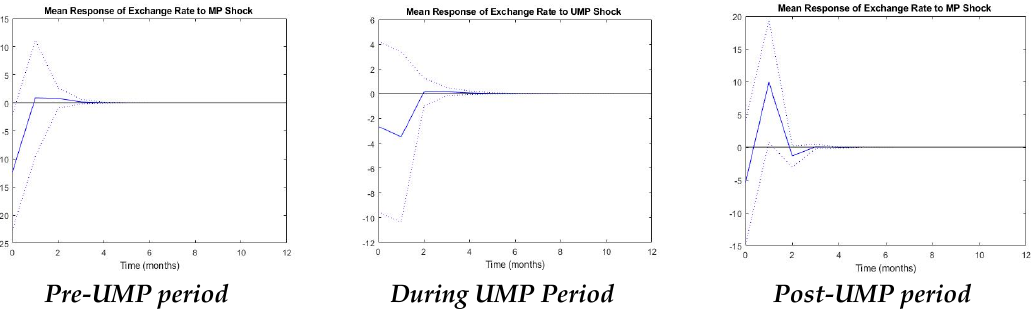
Figure 9. Mean responses of exchange rates in Asian developing economies to monetary policy shocks in pre-UMP, during UMP, and post-UMP periods .